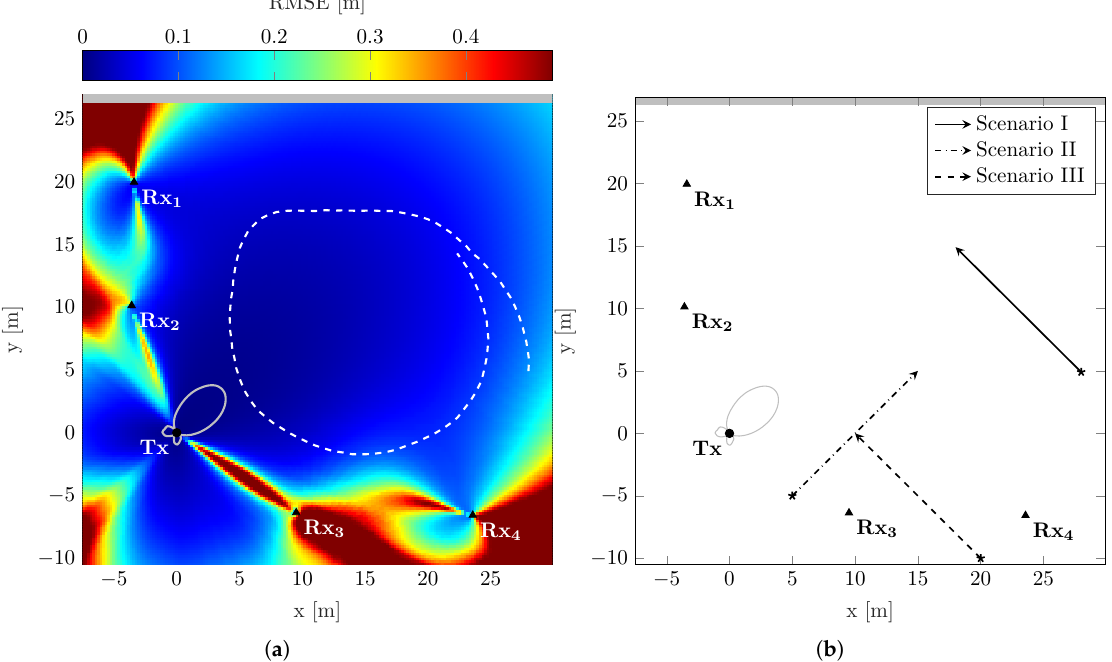
Figure 2. Overview of the measurement network, showing ( a ) the resulting CRLB on position estimation with dashed line as experiment trajectory, and ( b ) the three scenario trajectories for evaluating the PCRLB and the EKF; the trajectories represent the mean values of the position over a time period of 10s and indicate starting positions and moving